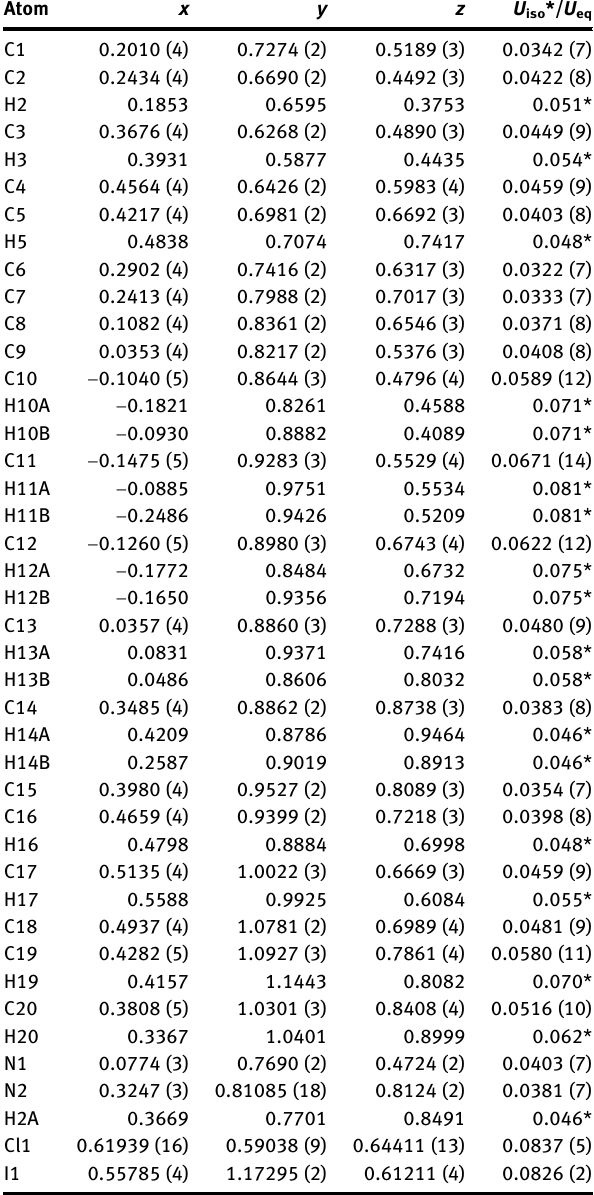
Table  : Fractional atomic coordinates and isotropic or equivalent isotropic displacement parameters (Å 